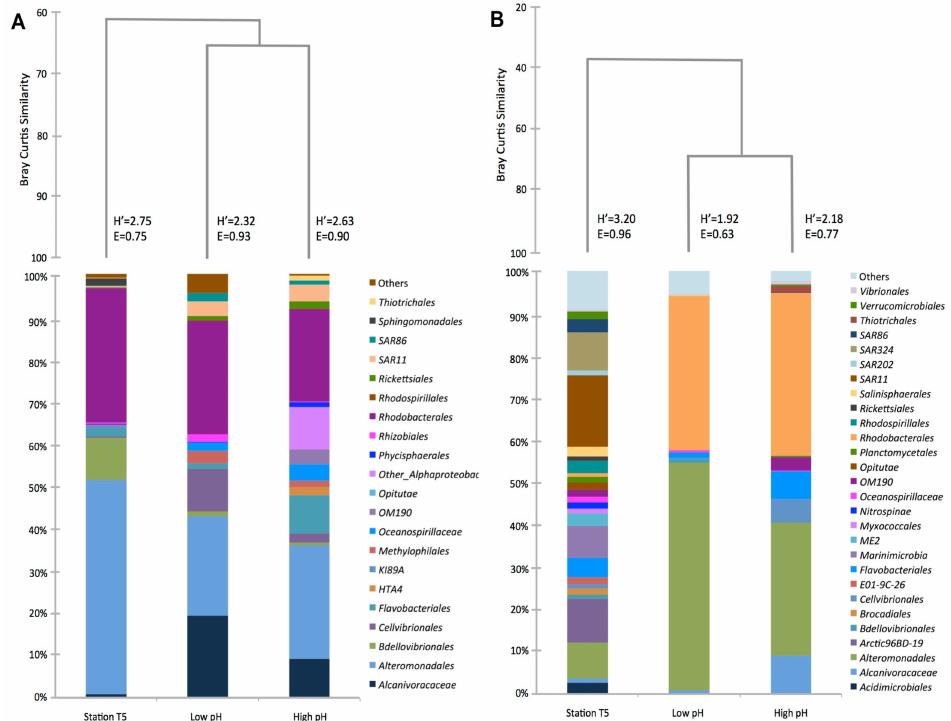
Figure 5. Cluster diagram of relative abundance of the most abundant taxa (above 1% in at least one sampling point in microcosm) assigned to bacterial phylogenetic groups obtained from station T5, treatment high pH / low p CO2 and treatment under pH / high p CO2 in two fraction sizes: ( A ) Free- living and ( B ) Particle attached), n = 3. H’ : Shannon diversity index, E : Evenness index. For free living, in the high pH / low p CO2 microcosms, Alteromonadales (26%), Other Alphaproteobacteria (10%), Rhodobacterales (22%,) Alcanivoracaceae (9%), and Flavobacteriales (9%) were the most